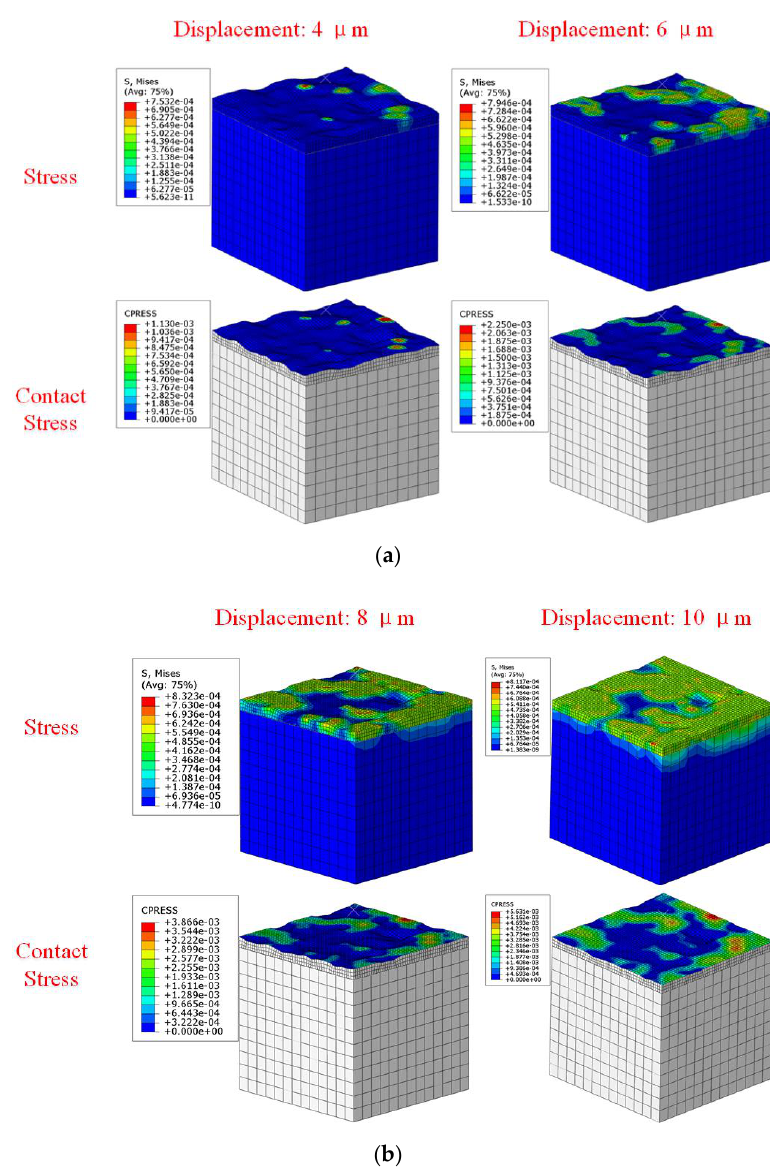
Figure 7. Stress and contact stress contour of gasket contact area under different loading displace- ment conditions (unit of stress and contact stress is N /μm 2 ): ( a ) displacement 4 μm and 6 μm, ( b ) displacement 8 μm and 10 μm .